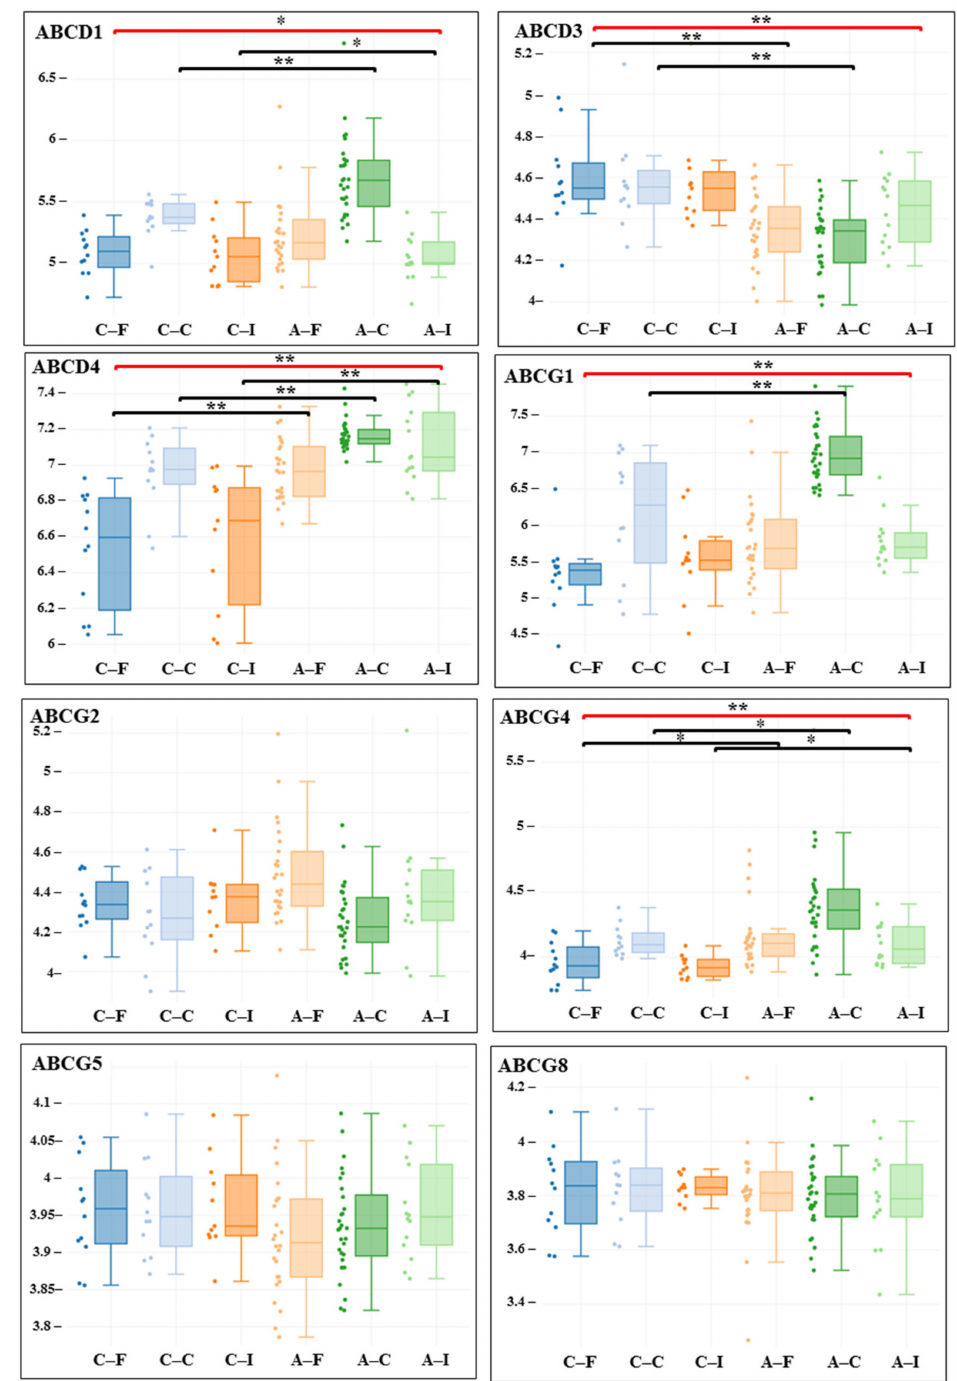
Figure 4. Gene expression patterns of the ABCD and ABCG subfamily in the comparison groups: atherosclerotic—femoral artery (A–F); atherosclerotic—carotid artery (A–C); atherosclerotic—infra- popliteal artery (A–I); control—femoral artery (C–F); control—carotid artery (C–C); control—infra- popliteal artery (C–I). The red line shows the differences in gene expression in the group between all sets with atherosclerosis and all control sets. The data distribution is visualized in the form of box diagrams. Statistically significant differences ( p values adjusted using the algorithm of Benjamini– Hochberg (adj. P. Val)) shown with asterisks: * p < 0.05, ** p <